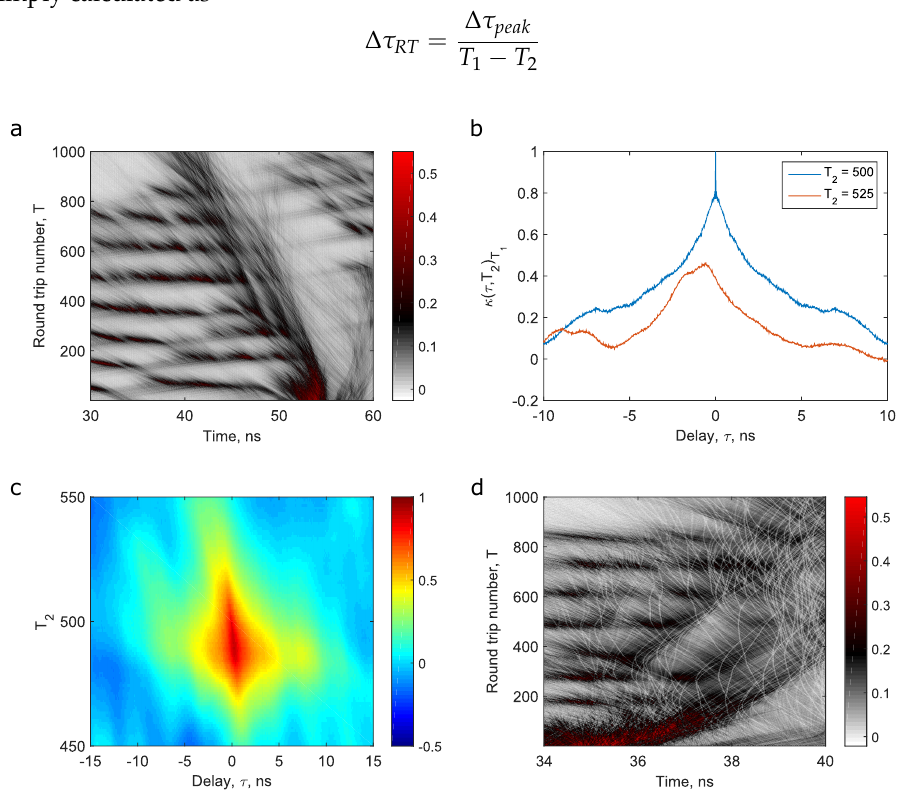
Figure 7. Cross-correlation based analysis for revealing the constituents of radiation—( a ) Spatio-temporal dynamics I ( t , T ) of the background region between the pulses for the regime of Figure 5c; ( b ) Cross correlation of intensity dynamics, κ ( τ , T 2 ) T is chosen to be the 500th round trip of Figure 7( a ); ( c ) Close up of cross correlation matrix κ ( τ , T 2 ) T The peak progressively shifting with T 2 indicates the possible existence of coherent features moving with a distinct velocity; and ( d ) the spatio-temporal dynamics of the background corresponding to its rest frame, revealing the existence of dark